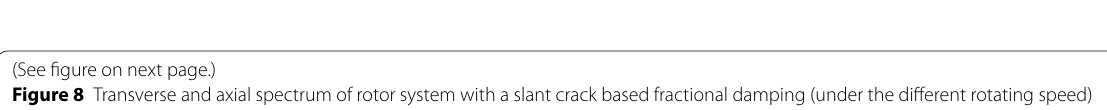
speed)(See figure on next Figure 8 Transverse and axial spectrum of rotor system with a slant crack based fractional damping (under the different rotating